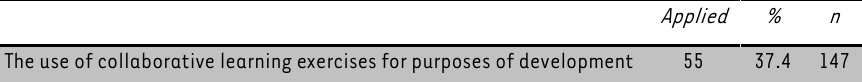
Academics’ views on their use of collaborative learning exercises after SAICA introduced the CF